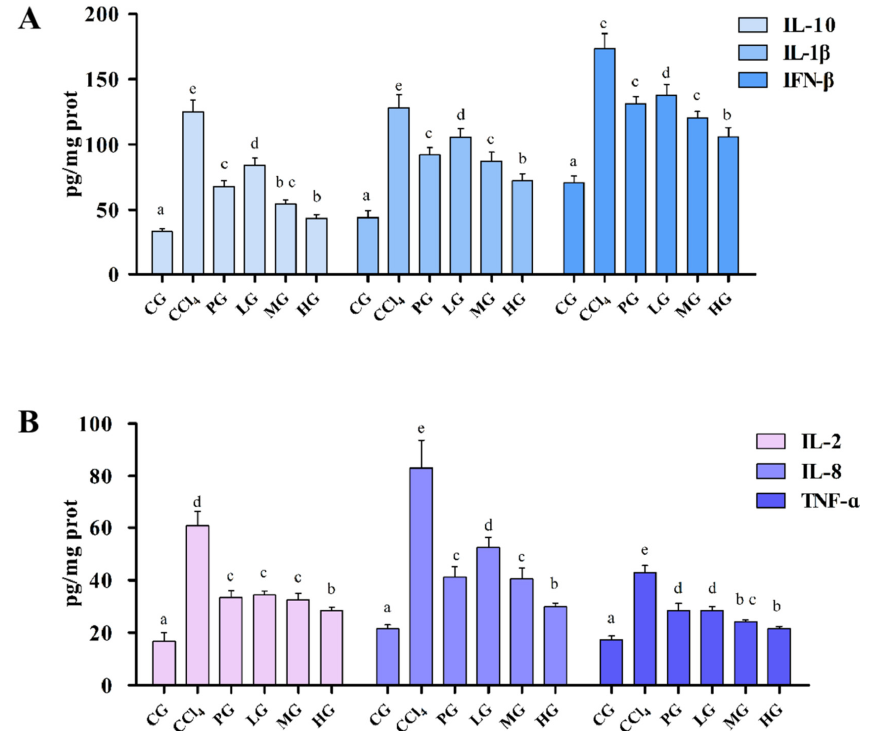
Figure 4. Effect of the ethanol extract of G42 on production of pro-inflammatory cytokines in liver determined using ELISA. ( A ) IL-10, IL-1 β , and IFN- β levels in liver tissues, ( B ) IL-2, IL-8, and TNF- α levels in liver tissues. Different letters above each bar in the same parameter indicate the significant difference ( p < 0.05) ( n =